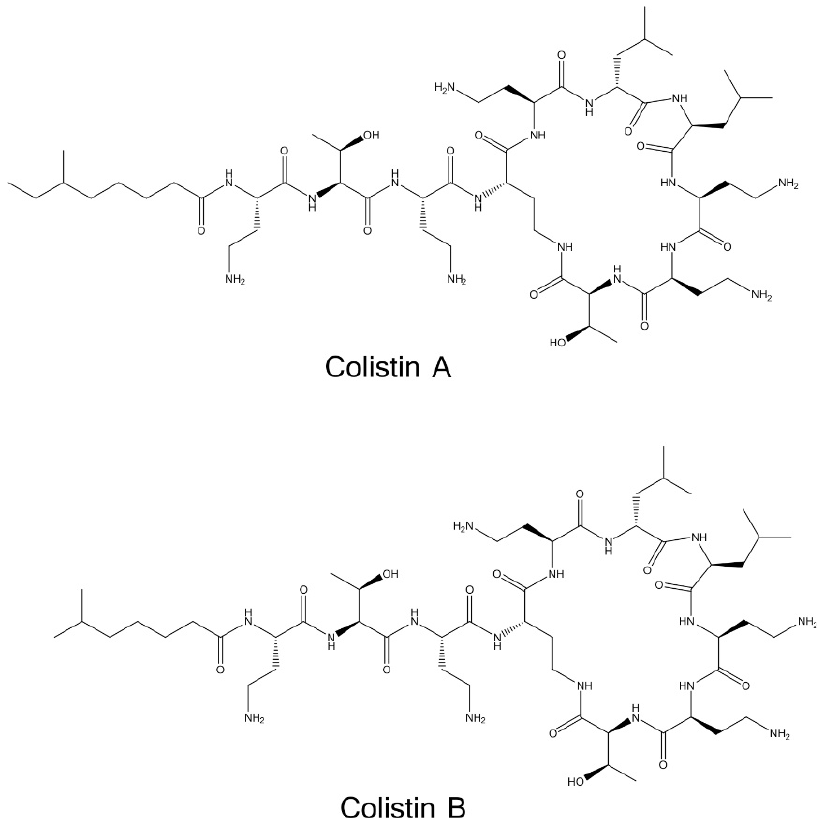
Figure 1. Chemical structures of Colistin A and Colistin B.